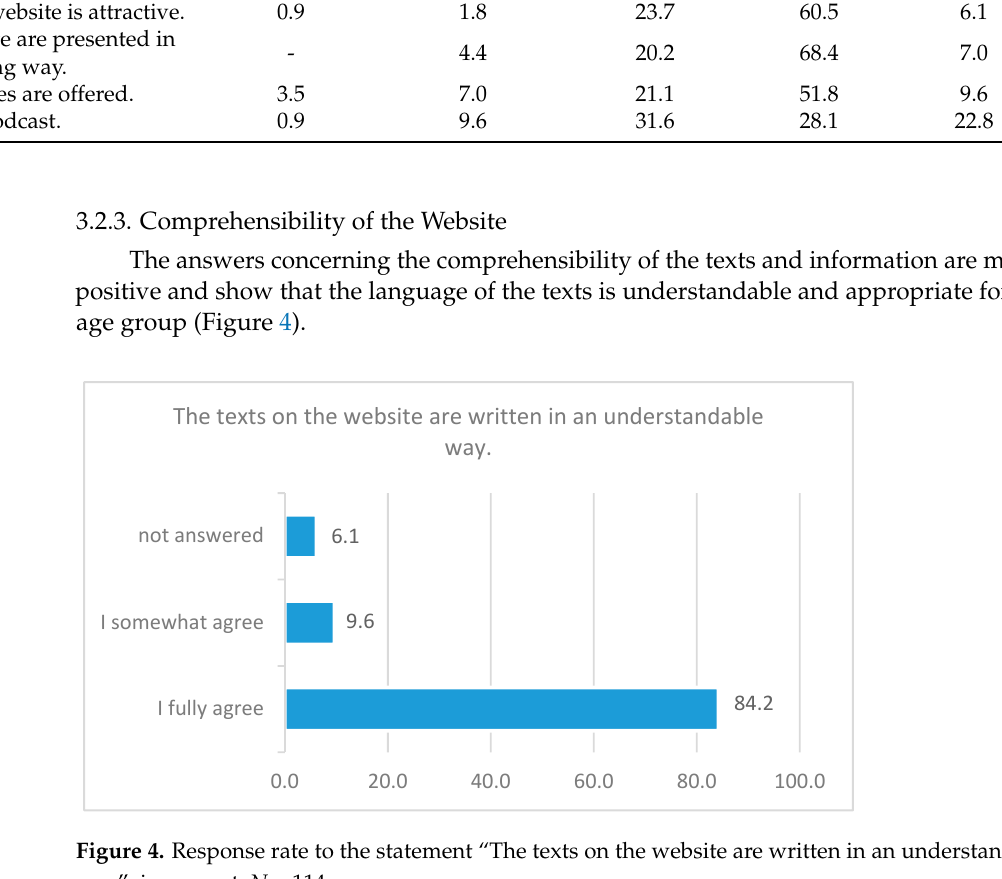
Table 4. Response rates to the statements concerning impulses for action (in percent, N = 114).